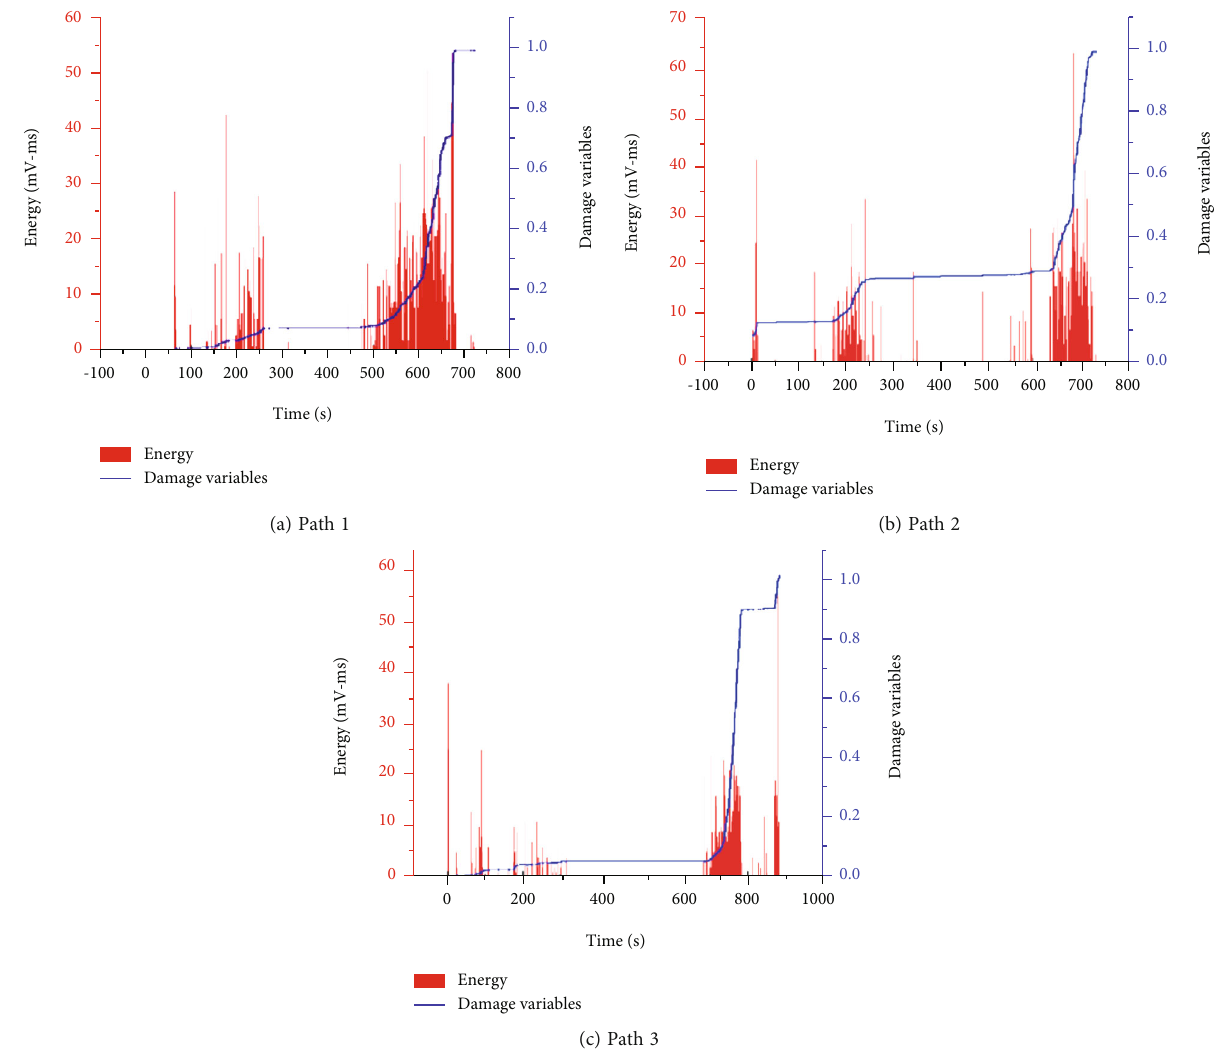
Figure 6: Diagram of AE energy and damage variables of coal body loaded under di ff erent stress